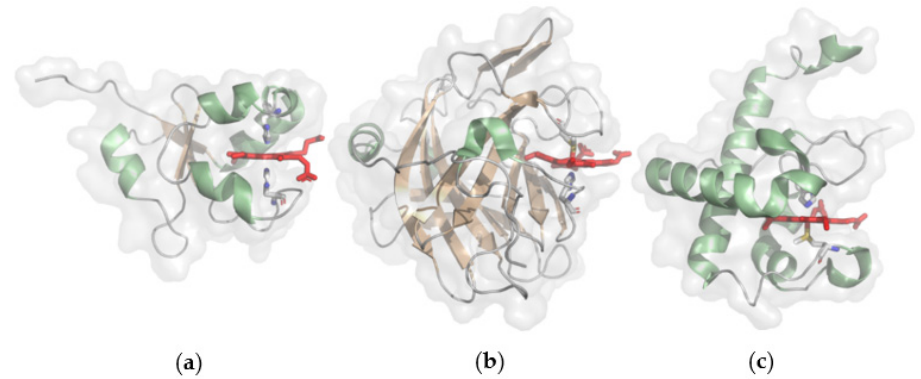
Figure 16. Cytochrome domain types with surface-exposed heme propionates (red sticks) frequently found in DET-capable multi-cofactor enzymes. ( a ) Heme b domain of Gallus gallus sulfitef oxidase (PDB: 1SOX) that structurally resembles b 5 -type cytochrome or b 2 cytochrome domain of L-lactate dehydrogenase; ( b ) heme b domain of Neurospora crassa cellobiose dehydrogenases (PDB: 4QI7), which can be also found in PQQ-pyranose dehydrogenases; ( c ) heme c 551 domain of Pseudomonas putida PQQ-dependent type II alcohol dehydrogenase (PDB: 1YIQ).